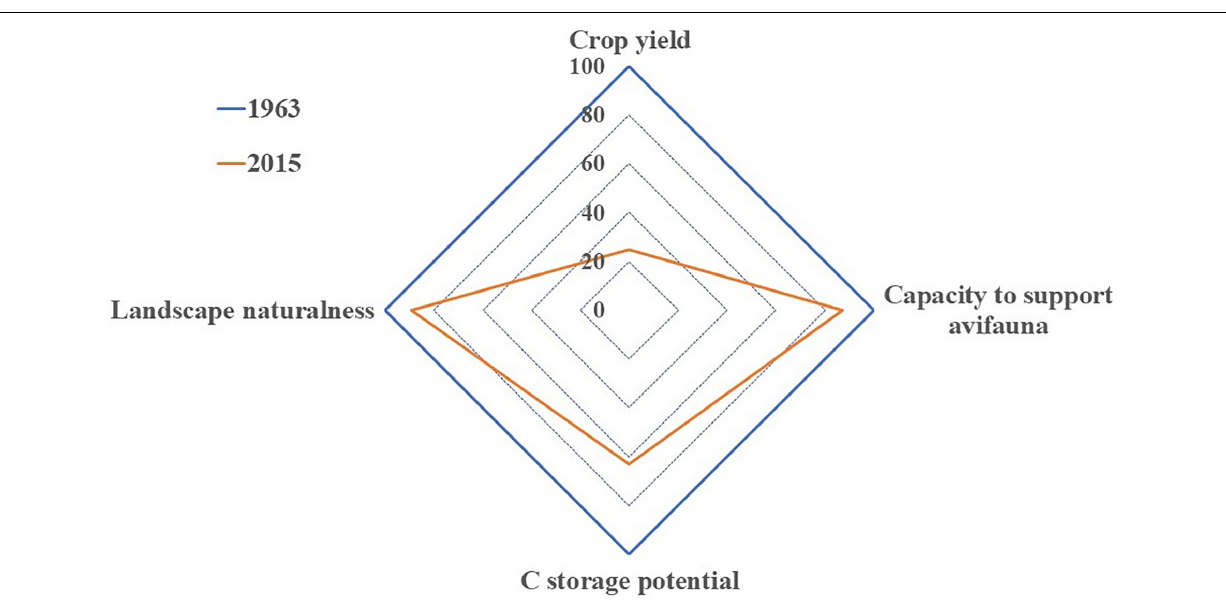
industrial sectors (Malavasi et al., 2013; Martínez-Fernández et al.,